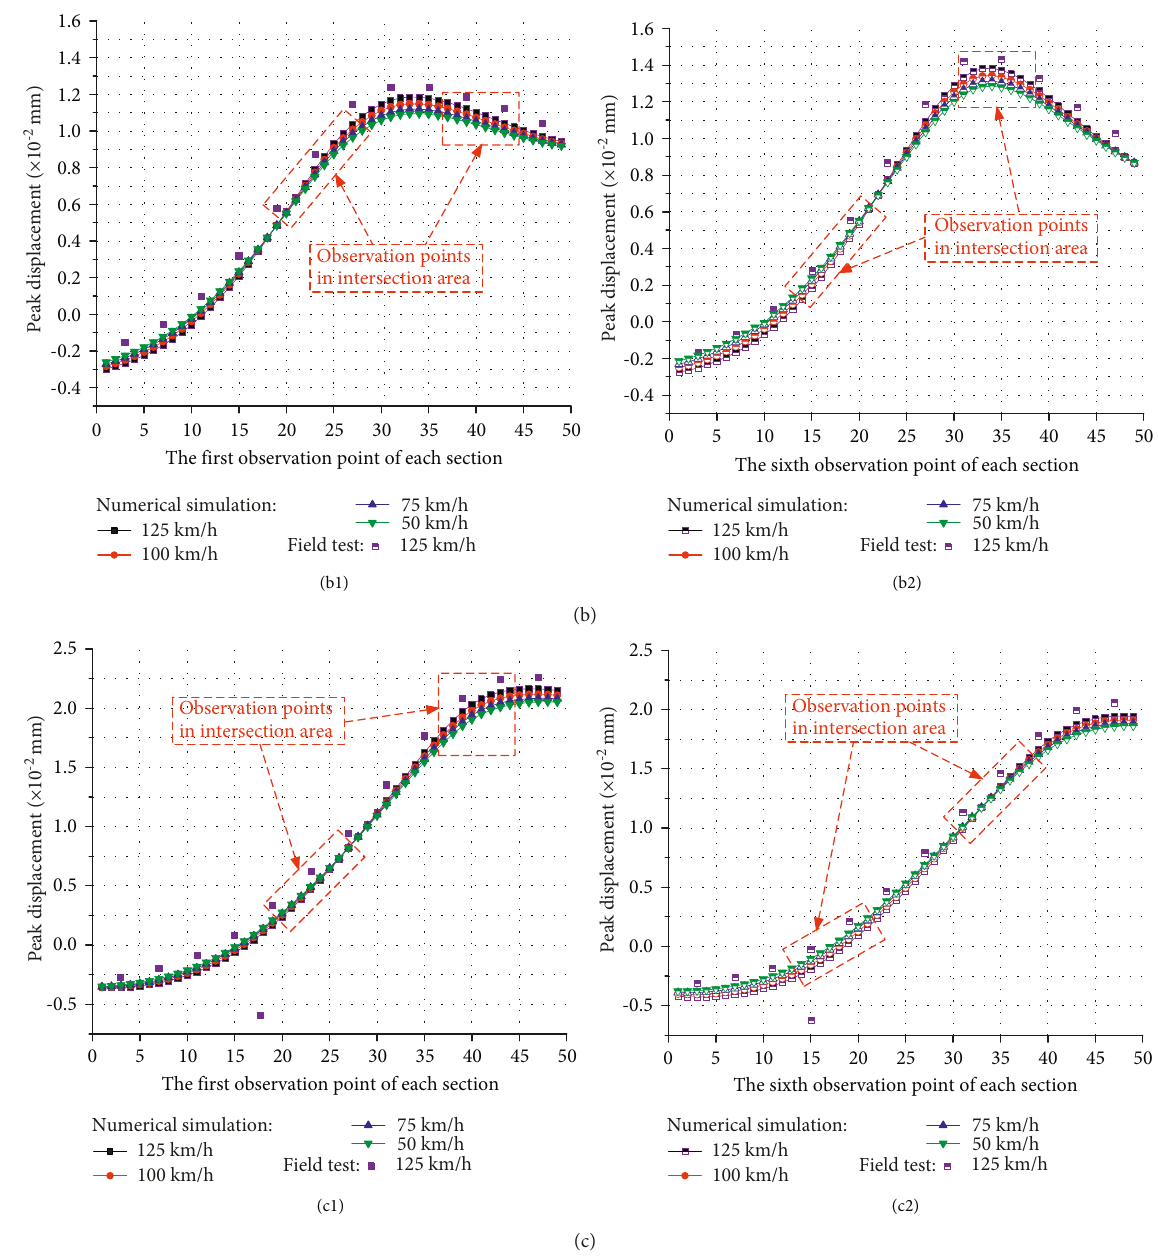
Figure 12: Peak displacement of observation points on existing tunnel: (a) shield excavation reaches the 38 th ring on the right; (b) shield excavation reaches the 52 th ring on the right; (c) shield excavation reaches the 67 th ring on the